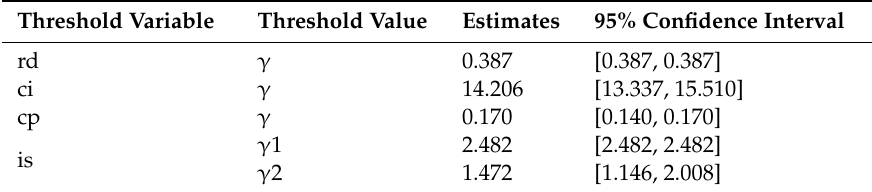
Table 4. Threshold estimation results and confidence intervals of loan size and carbon emissions.